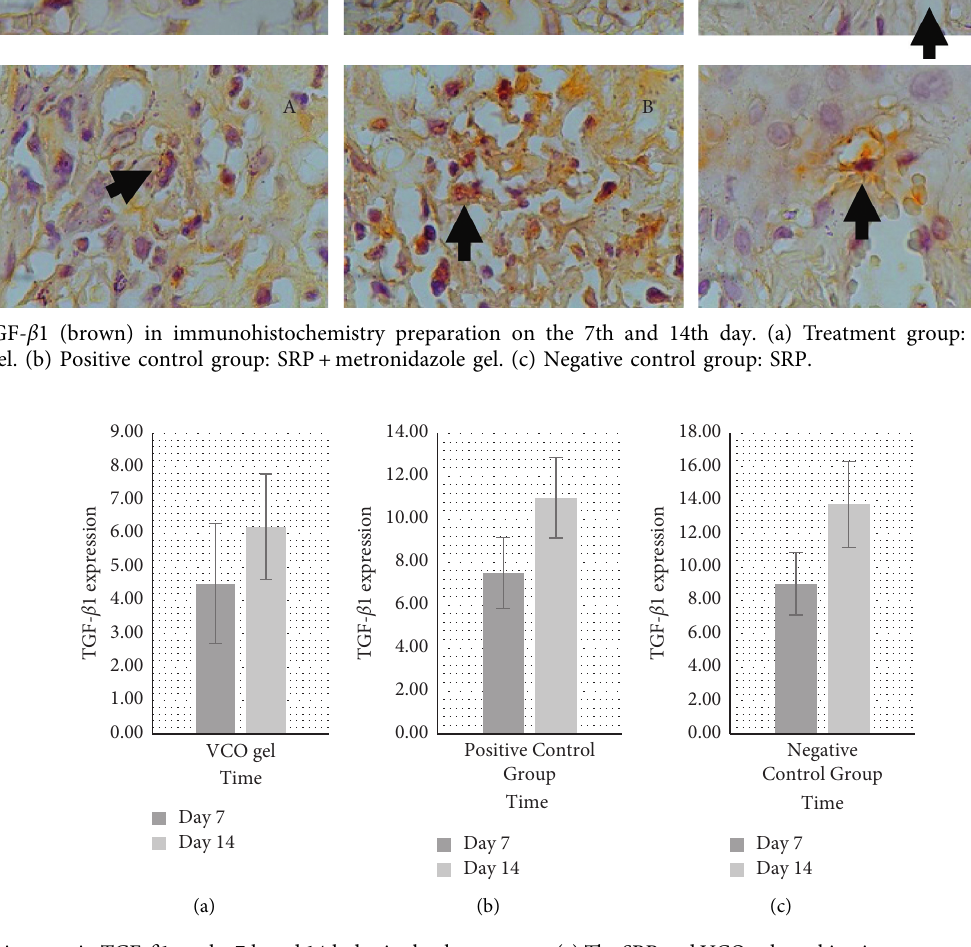
Figure 6: The increase in TGF- β 1 on the 7th and 14th day in the three groups. (a) The SRP and VCO gel combination treatment group has small increase. (b) The group that received VCO gel and metronidazole gel has higher increase, as well as (c) the negative control group with SRP